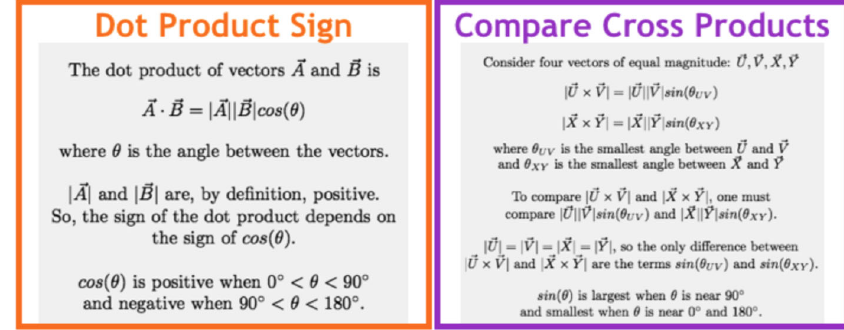
FIG. 2. Examples of EF images used in dot or cross product